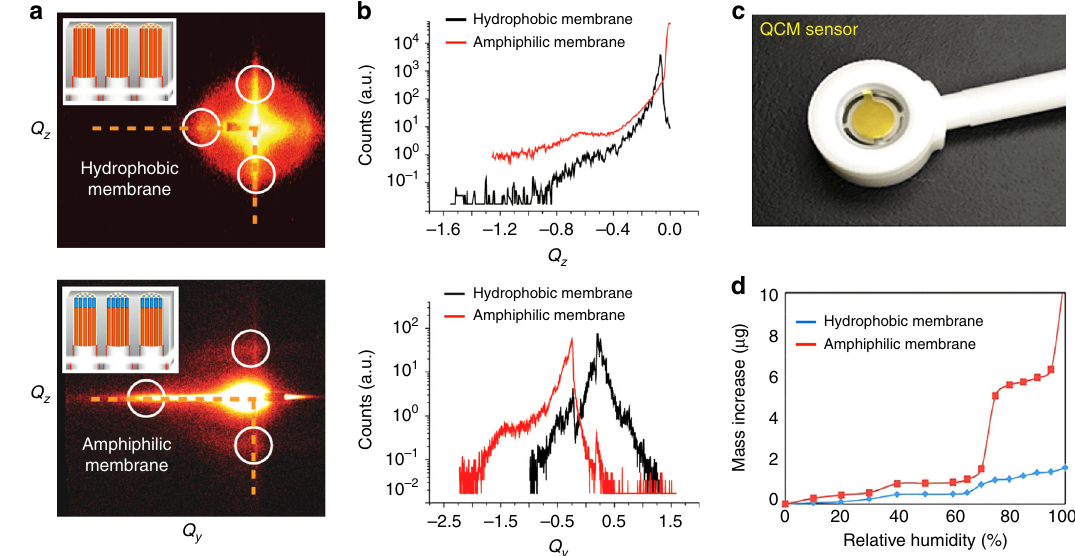
Fig. 6 GISAXS and water adsorption isotherm characterization of hydrophobic and amphiphilic membranes. a GISAXS characterization of the hydrophobic and amphiphilic-surface-modi fi ed membrane showing a similar mesoporous structure. b Linecuts of GISAXS showing the similarity of two membranes. c Photograph of a 25-mm-wide quartz crystal microbalance (QCM) mass sensor coated with a P123-templated mesoporous silica fi lm. d QCM mass increase as a function of % relative humidity (RH) for the hydrophobic and amphiphilic membranes showing sudden water adsorption in the amphiphilic membrane (at RH = 75%) due to the capillary condensation of water vapor on the hydrophilic top surface. The mass of condensed water vapor establishes the water volume, from which we calculate the average thickness of the nano-stabilized liquid membrane geometrically assuming that the amphiphilic- surface modi fi ed membrane uniformly coats the QCM